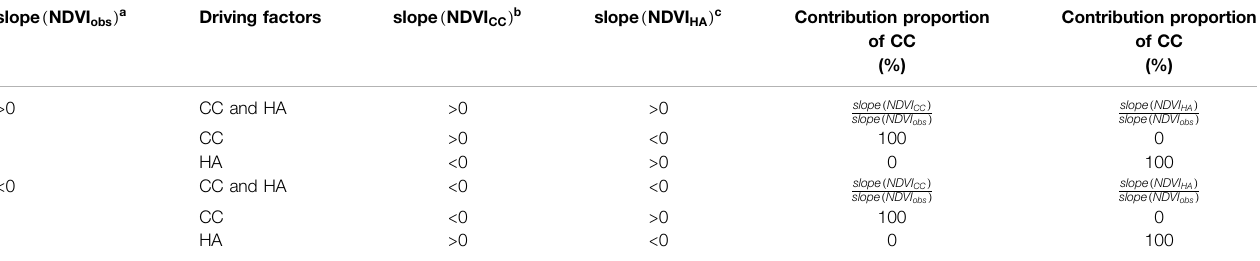
TABLE 2 | Identi fi cation criterion and contribution calculation of the drivers of NDVI change. slope ( NDVI obs )